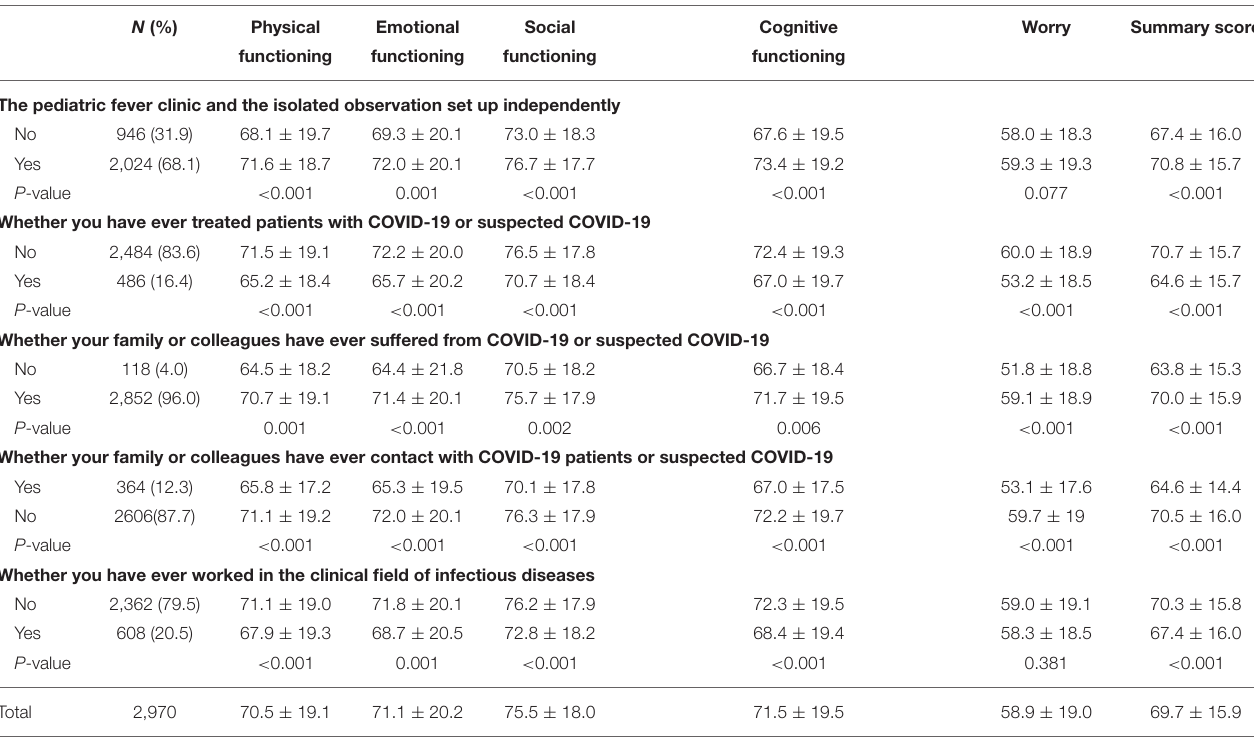
TABLE 2 | HRQoL based on COVID-19 protection related characteristics ( x ± s ).